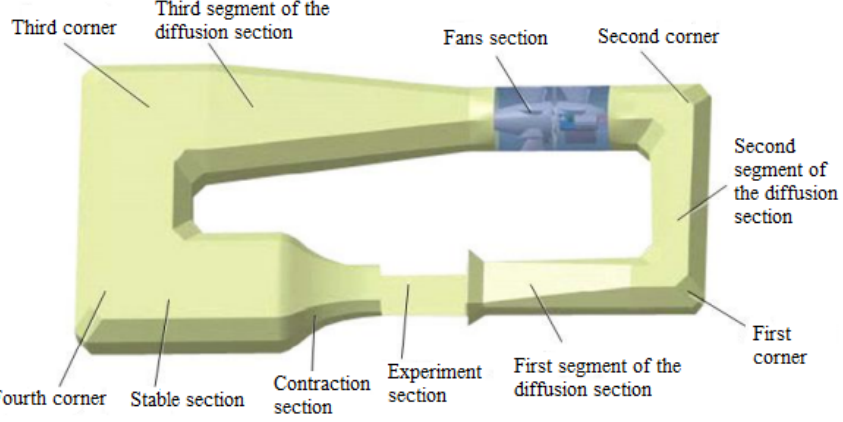
Figure 1. Wind tunnel in Jilin University.